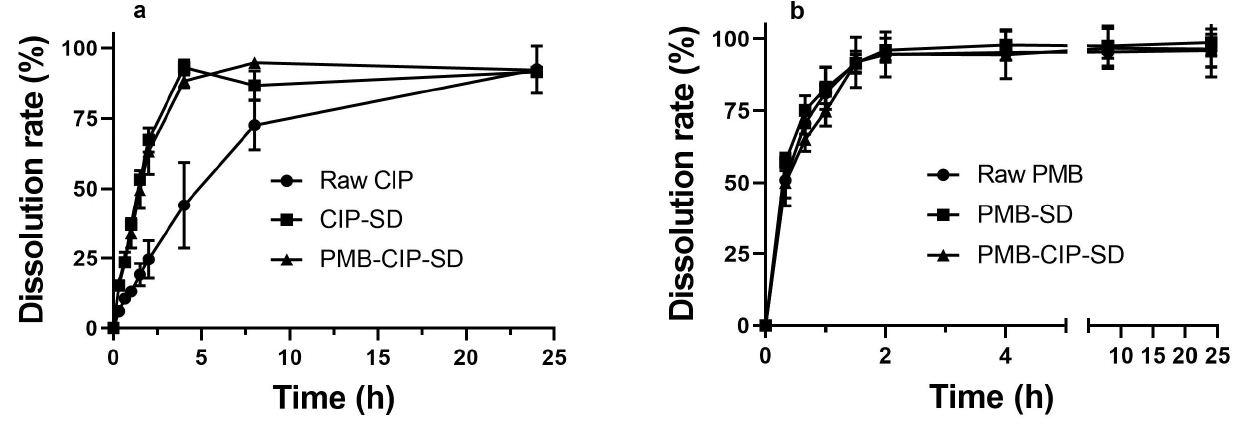
Figure 5. In vitro accumulated dissolution profiles of CIP ( a ) and PMB ( b ) (mean ± SD, n = 3).